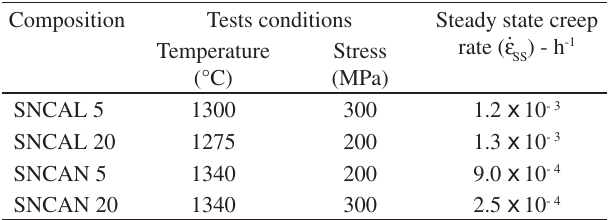
Table 3. Creep results of the hot pressed